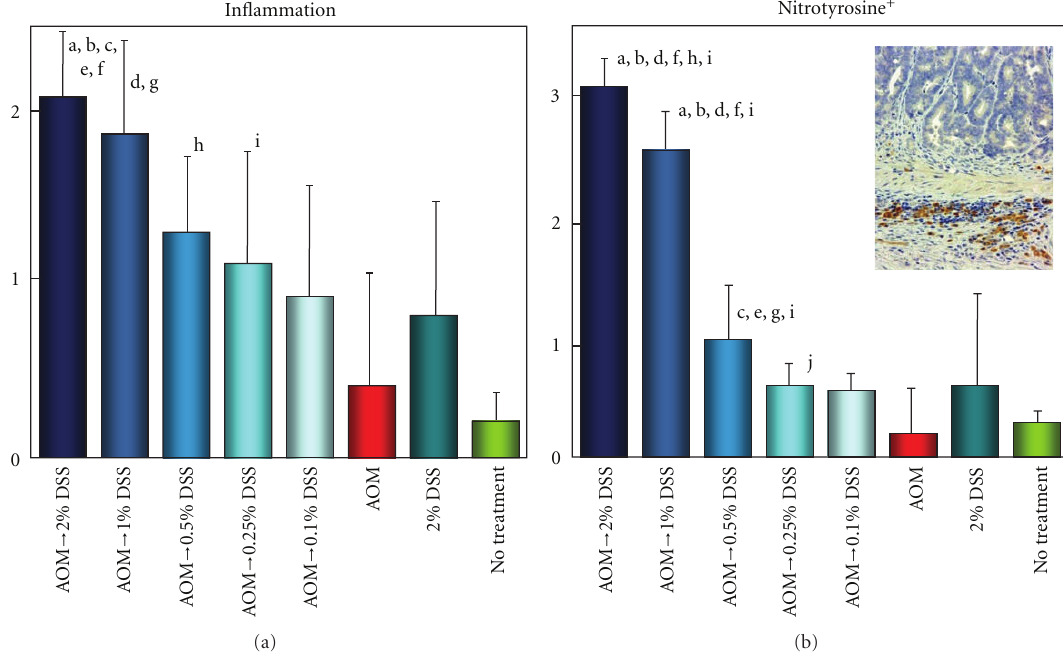
Figure 9: Inflammation and nitrotyrosine-positive scores in the colon of mice that received AOM and/or DSS (0.1%, 0.25%, 0.5%, 1%, or 2% DSS in drinking water). (a) Significantly di ff erent: a ( P < 0 . 05), versus AOM → 0.5% DSS group; b ( P < 0 . 05), versus AOM → 0.1% DSS group; c ( P < 0 . 01) and d ( P < 0 . 05), versus AOM alone group; e ( P < 0 . 05), versus 2% DSS alone group; and f ( P < 0 . 001), g ( P < 0 . 005), h ( P < 0 . 01), and i ( P < 0 . 05), versus no treatment group. (b) Significantly di ff erent: a ( P < 0 . 001), versus AOM → 0.5% DSS group; b ( P < 0 . 001) and c ( P < 0 . 05), versus AOM → 0.25% DSS group; d ( P < 0 . 001) and e ( P < 0 . 01), versus AOM → 0.1% DSS group; f ( P < 0 . 001) and g ( P < 0 . 05), versus AOM alone group; h ( P < 0 . 005), versus 2% DSS alone group; and i ( P < 0 . 001) and j ( P < 0 . 05), versus no treatment